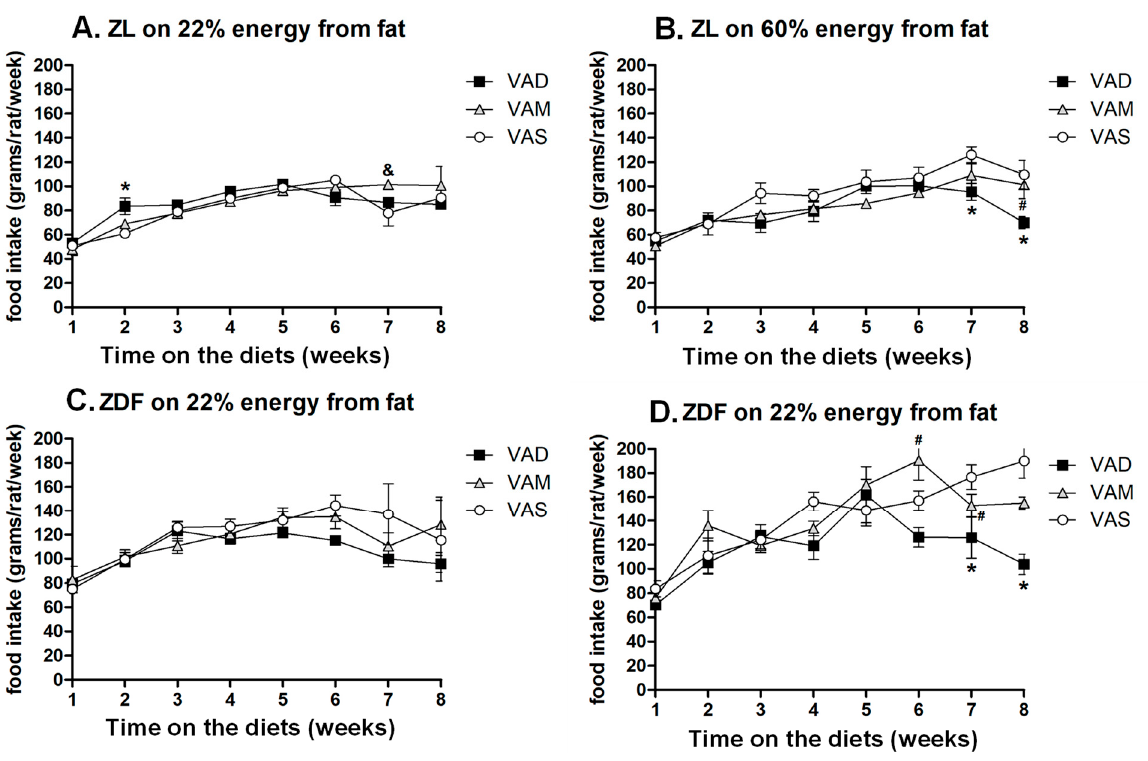
Figure 2. Food intake of ZL or ZDF rats fed a VAD, VAM or VAS diet with BF or HF content for 8 Weeks . The average amounts of food intake in the ZL or ZDF rats fed the indicated diets were measured weekly. Data are expressed as mean ± SEM; n = 5–6 per group; * VAD vs. VAS, # VAD < VAM, & VAM > VAS; all p < 0.05.